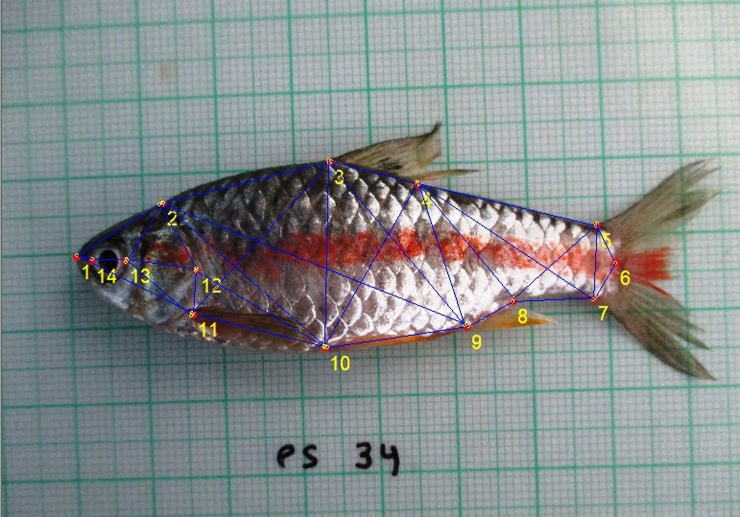
Puntius sophore representing locations of 14 landmarks and the distances measured which were used for morphological variations.Landmarks refer to: (1) anterior tip of snout at upper jaw (2) most posterior aspect of neurocranium (beginning of scaled nape) (3) origin of dorsal fin (4) end of dorsal fin (5) anterior attachment of dorsal membrane from caudal fin (6) posterior end of vertebrae column (7) anterior attachment of ventral membrane from caudal fin (8) end of anal fin (9) origin of anal fin (10) insertion of pelvic fin (11) insertion of pectoral fin (12) end of operculum (13) posterior end of eye (14) anterior end of eye.